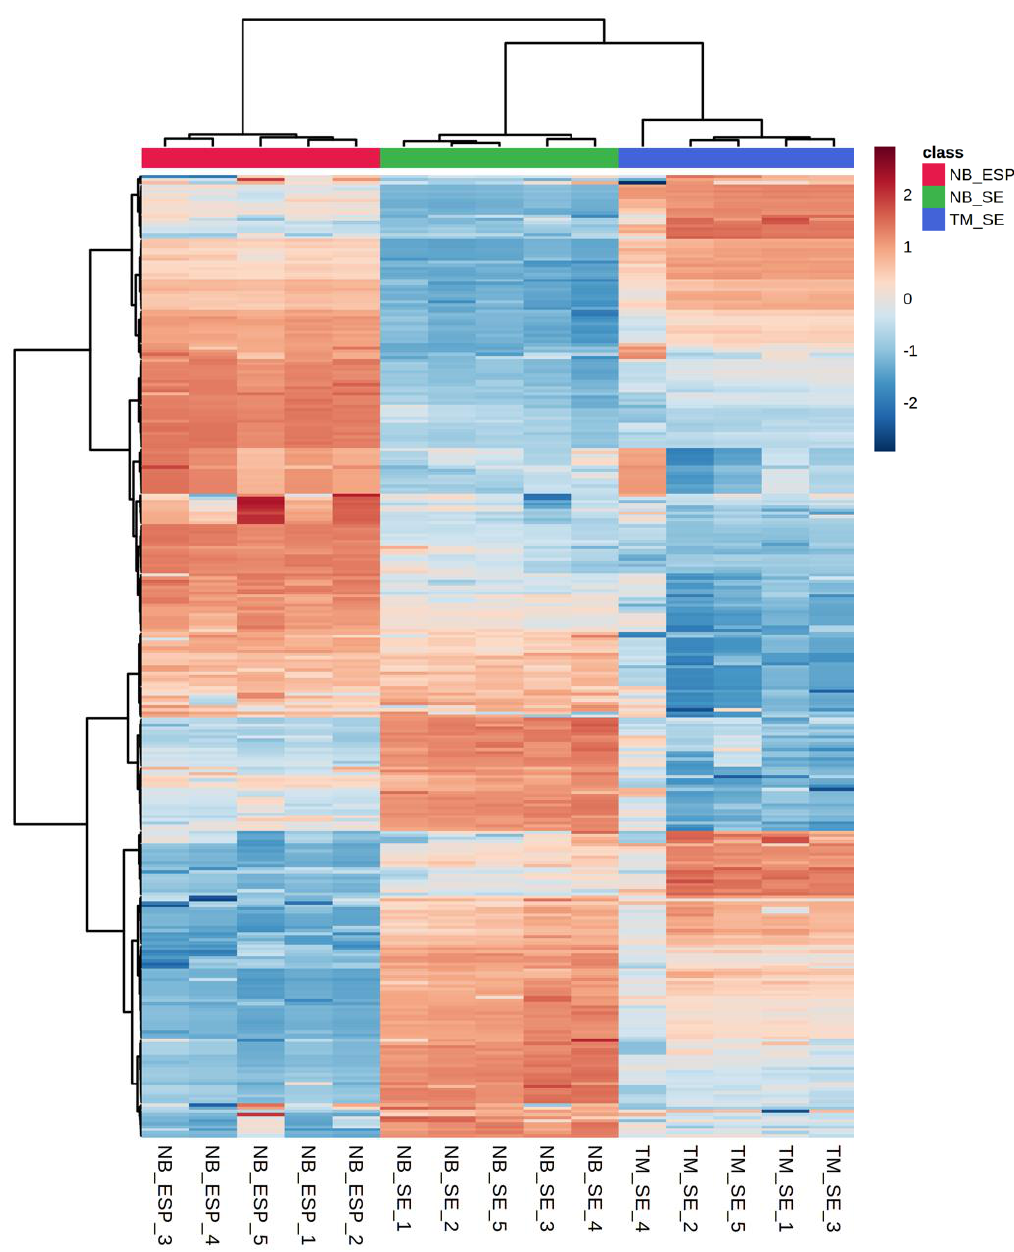
Figure 9. Hierarchical clustering analysis (HCA) of the three samples (the somatic extract of infective third-stage larvae (L3) of N. brasiliensis (NB_SE), the excretory/secretory products (ESP) of N. brasiliensis L3 (NB_ESP), and the somatic extract of T. muris embryonated eggs (TM_SE)), showing discrimination between the sample types and differential abundances of 350 putative lipids. Each row represents putative lipids, and each column represents the biological replicates of an individual sample group. The scale bar represents the normalised intensity of metabolites, where blue colour indicates low/decrease, and red colour indicates high/increase. Media (QC_Media) and pooled quality control (QC_P) values were excluded from the analysis, as they were subtracted from the samples. Note: Heat-map was purposefully generated on all 350 putative lipids to show the overall pattern between the sample groups. For specific lipid details with peak areas, refer to Supplementary Table S2.